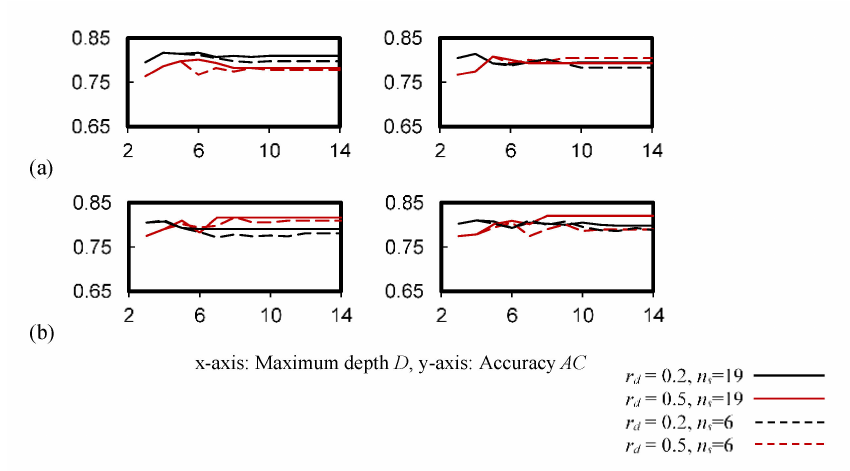
Figure 6. Cross-validation accuracy of the decision tree classifier. ( a ) Entropy impurity, n r = 6 ( b ) Gini impurity, n r = 2.